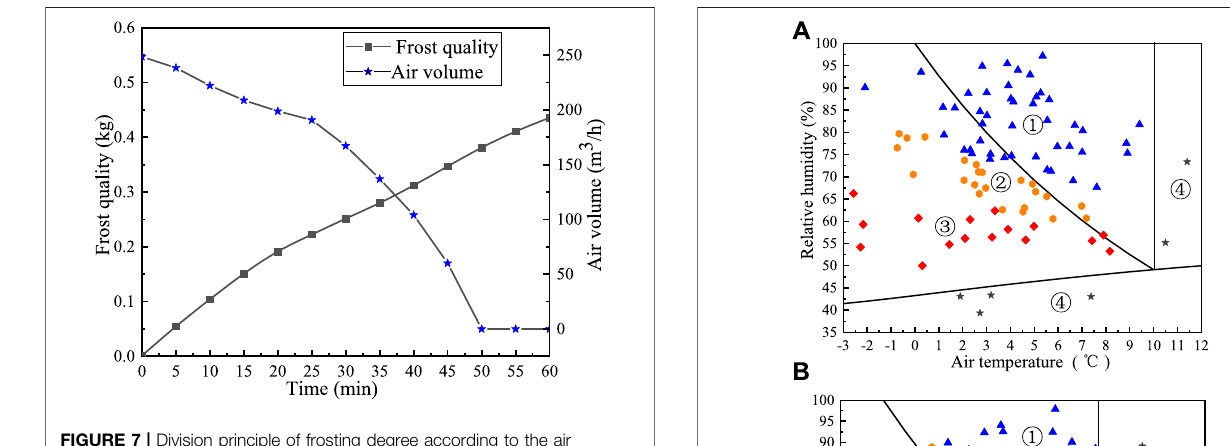
FIGURE 7 | Division principle of frosting degree according to the air volume attenuation.